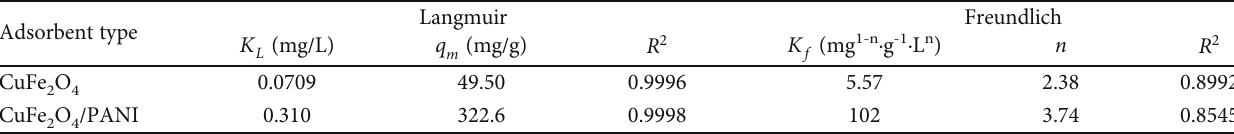
Table 3: Langmuir and Freundlich isotherm adsorption constants of CuFe uranium adsorption.